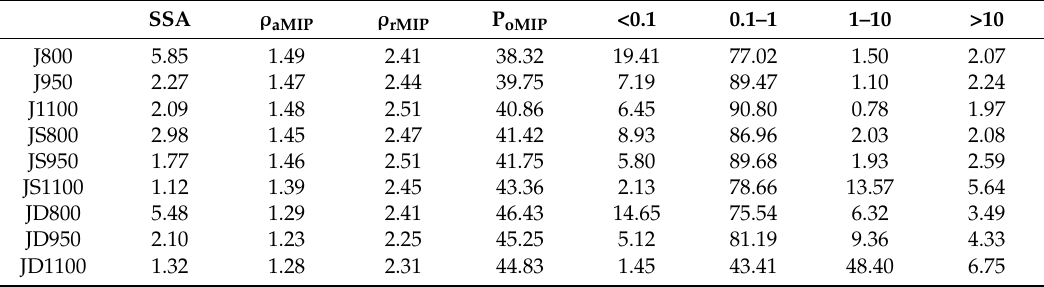
Figure 5. Pore size distribution curves for bricks with and without additives fired at 800, 950, and 1100 ◦ C. Pore radius (in µ m) versus log (DV/Dr) (in mL/g). The radius at the maximum peak is indicated. Table 3. Results of MIP test on brick samples with and without additives fired at 800, 950, and 1100 ◦ C. SSA = specific surface area (m 2 /g); ρ aMIP = apparent density (g · cm − 3 ); ρ rMIP = real density (g · cm − 3 ); P oMIP = open porosity (%); relative porosity distribution (%) according to pore size ranges (<0.1, 0.1–1, 1–10, >10 µ